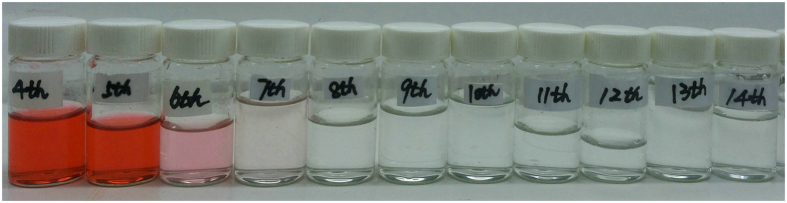
The optical photograph of the red-ink samples.